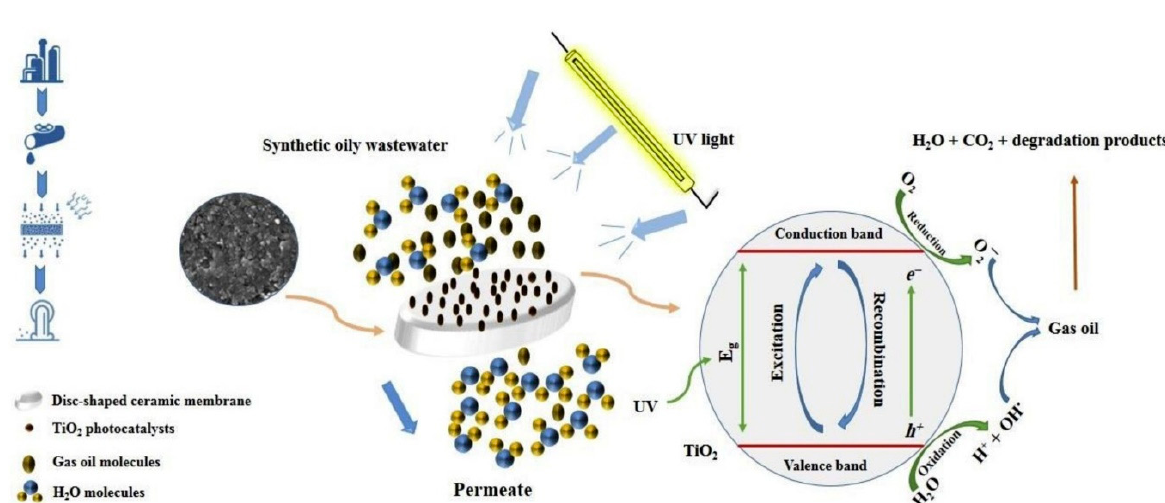
Figure 13. Example of a hybrid system of advanced oxidation process (AOP) using photocatalytic reactor and microfiltration (MF) ceramic membrane. Reprinted with permission from ref. [233]. Copyright 2020 Elsevier Ltd.